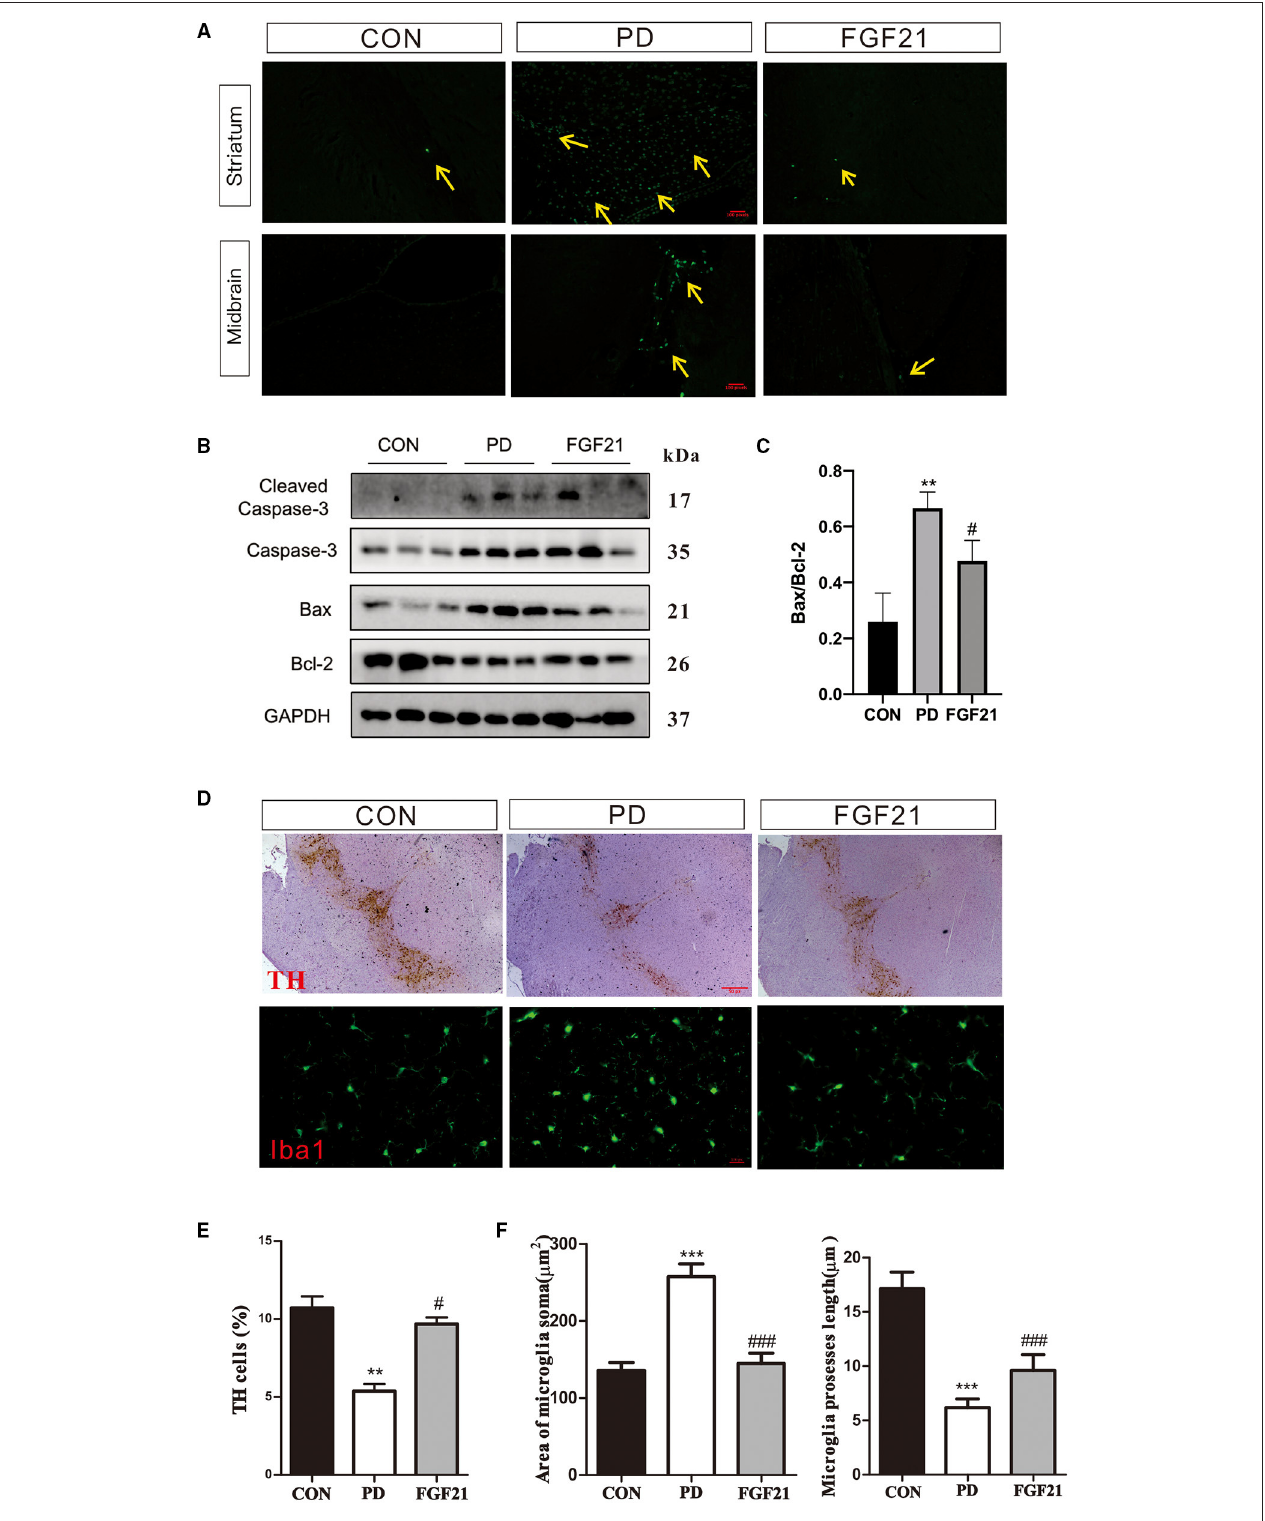
FIGURE 3 | FGF21 treatment rescued PD-like pathology in mice with PD. (A) TUNEL assay. (B) Protein levels of Bcl-2, Bax, and cleaved caspase-3 in the midbrain. (C) Bcl-2/Bax ratio. (D) tyrosine hydroxylase (TH), and Iba-1 immunostaining. (E) TH-positive neurons in midbrain. (F) Microglia soma and microglia process length in midbrain. Data are mean ± s.e.m.; n = 12 for each group. A one-way ANOVA analysis was conducted followed by an LSD multiple comparison test. * P < 0.05, ** P < 0.01, *** P < 0.001 vs. CON group; # P < 0.05, ## P < 0.01, ### P < 0.001 vs. MPTP-injected mice.